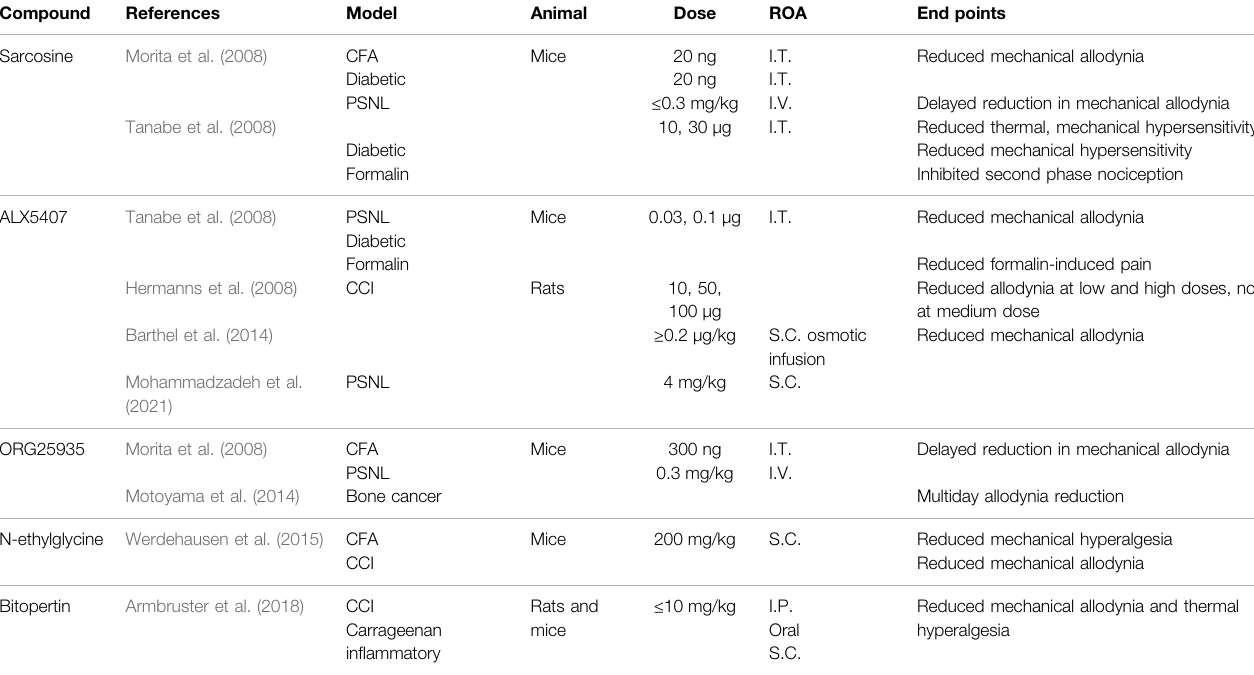
TABLE 1 | Experiments investigating known GlyT1 inhibitors. I.T., intrathecal; I.V., intravenous; S.C., subcutaneous; I.P., intraperitoneal; ROA., route of administration.